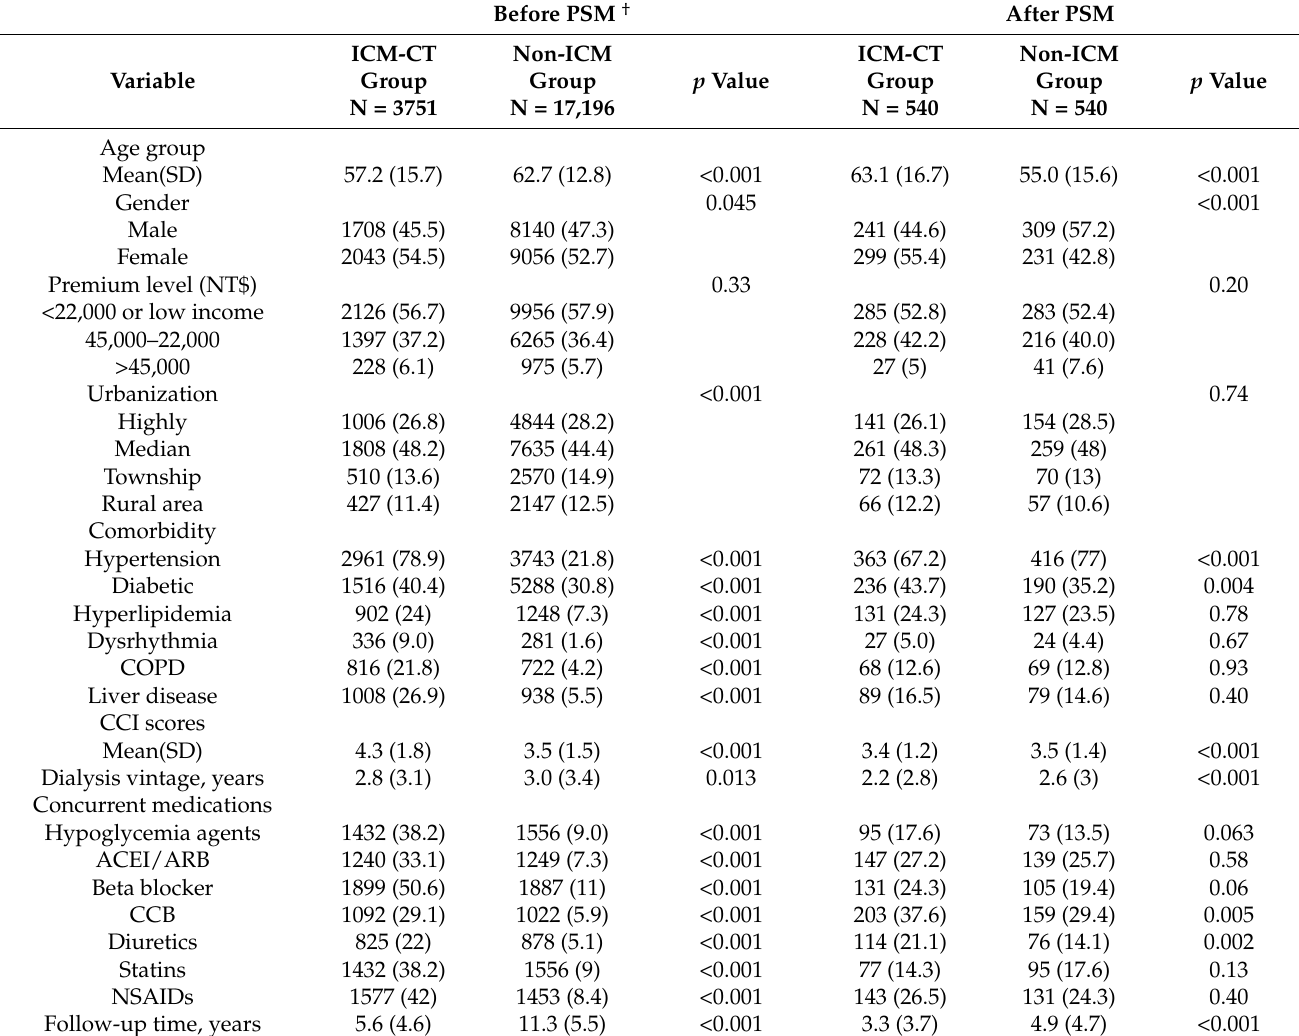
Table 1. Baseline characteristics of study cohorts before and after propensity score matching process. Before PSM † After